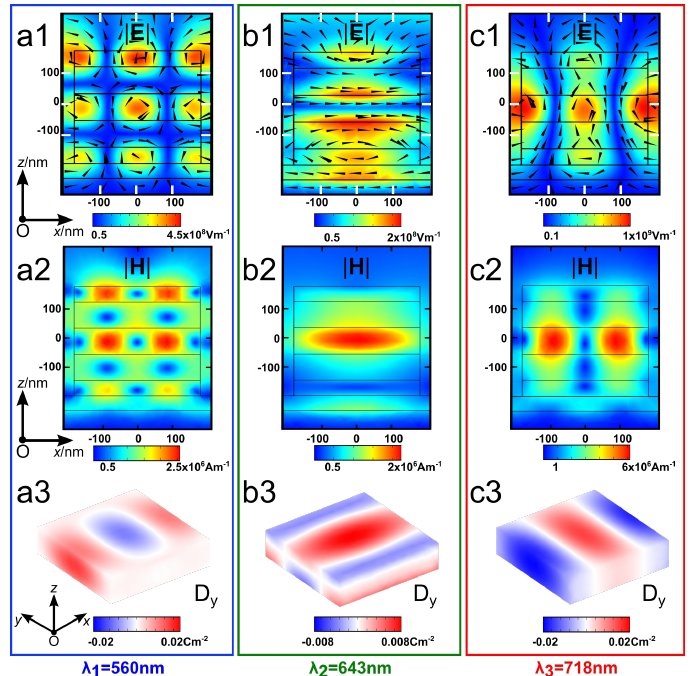
Figure 2. Electric field norm (| E |) distribution in the xOz plane ( a1 – c1 ), magnetic field norm (| H |) distribution ( a2 – c2 ), and 3D views of the electric displacement field, y direction ( D y ) in the center layer of the cavity ( a3 – c3 ), for the three characteristic resonances λ 1 = 560 nm (first column), λ 2 = 643 nm (second column) and λ 3 = 718 nm (third column). Arrows in ( a1 – c1 ) denote corresponding magnetic field